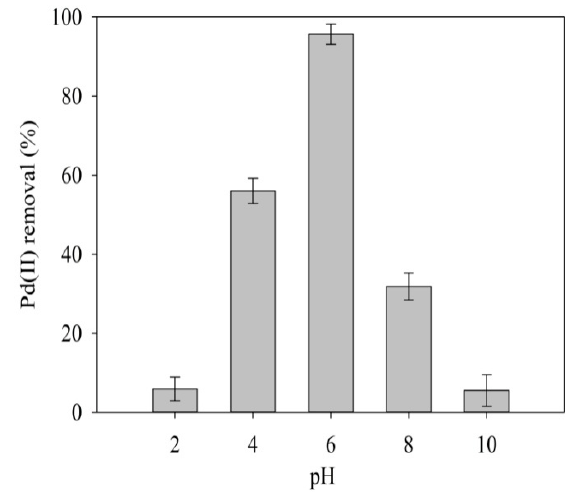
Figure 4. Pd(II) removal under different pH (2, 4, 6, 8, 10) at initial Pd(II) concentration of 100 mg/L and experimental time of 10 h.